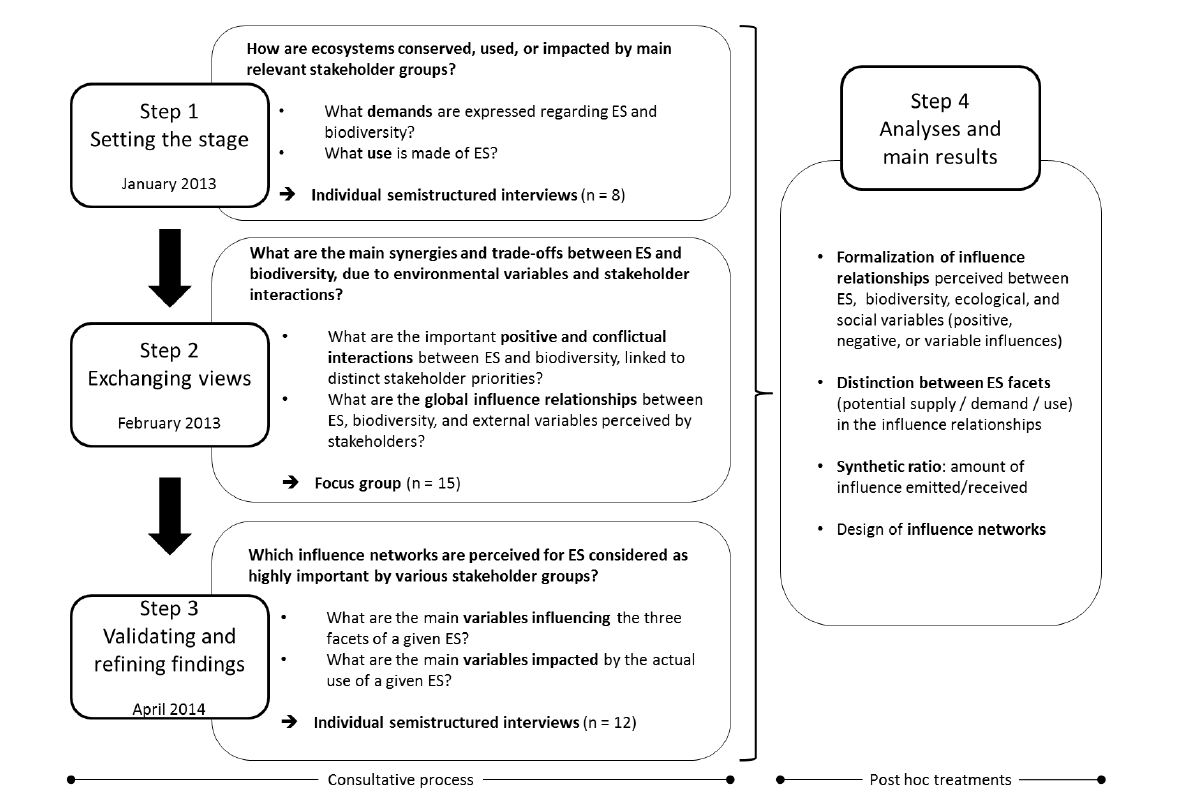
Fig. 3 . Consultative process steps and related questions to explore ecosystem service (ES) networks in the French Alps using the influence network framework